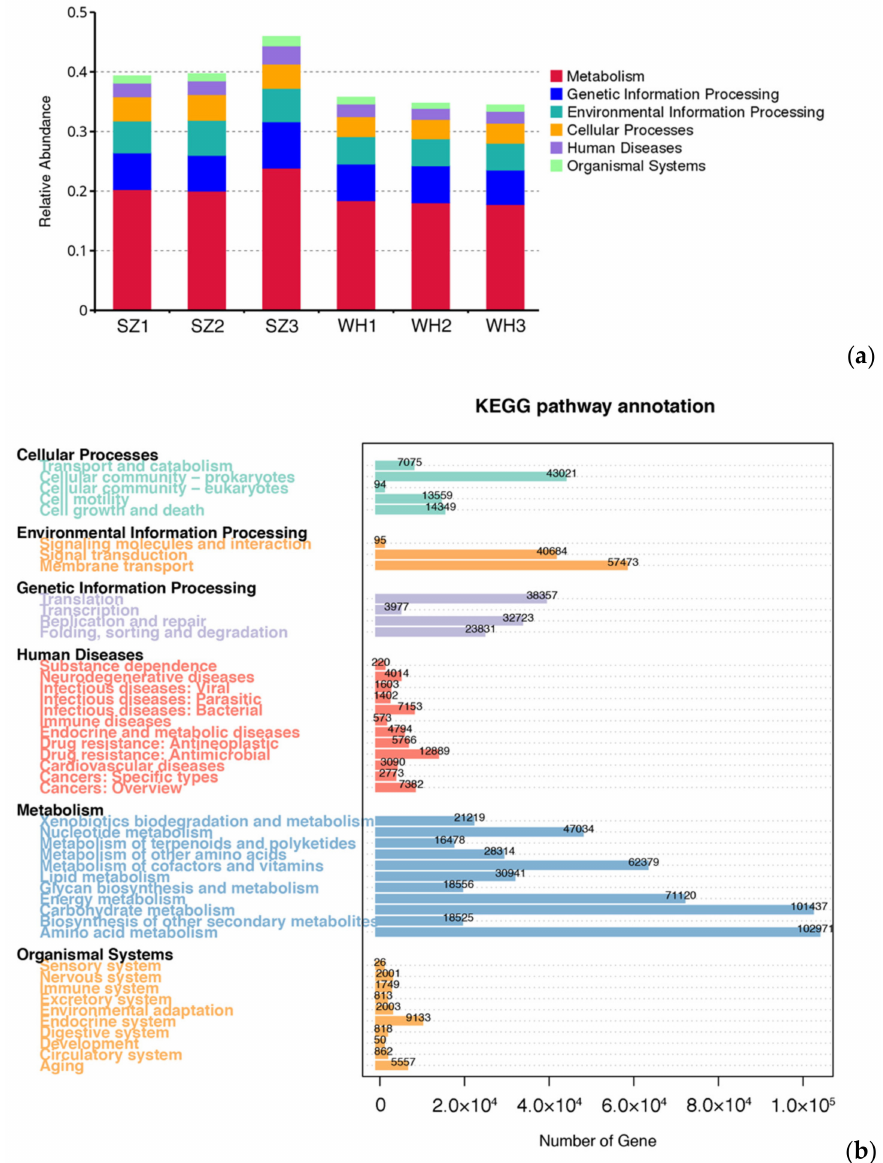
Figure 4. Gene function prediction by KEGG: ( a ) Relative abundances of KEGG level 1 in each sample. ( b ) The number of genes annotated in KEGG level